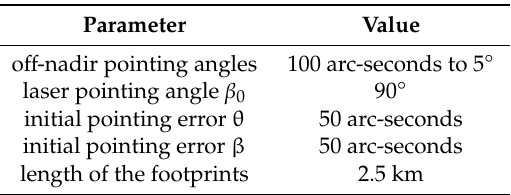
Table 4. Experimental parameters.